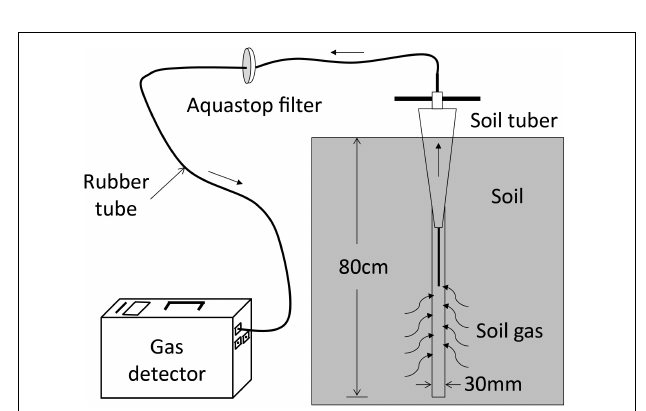
FIGURE 2 | Schematic diagram of soil gasses